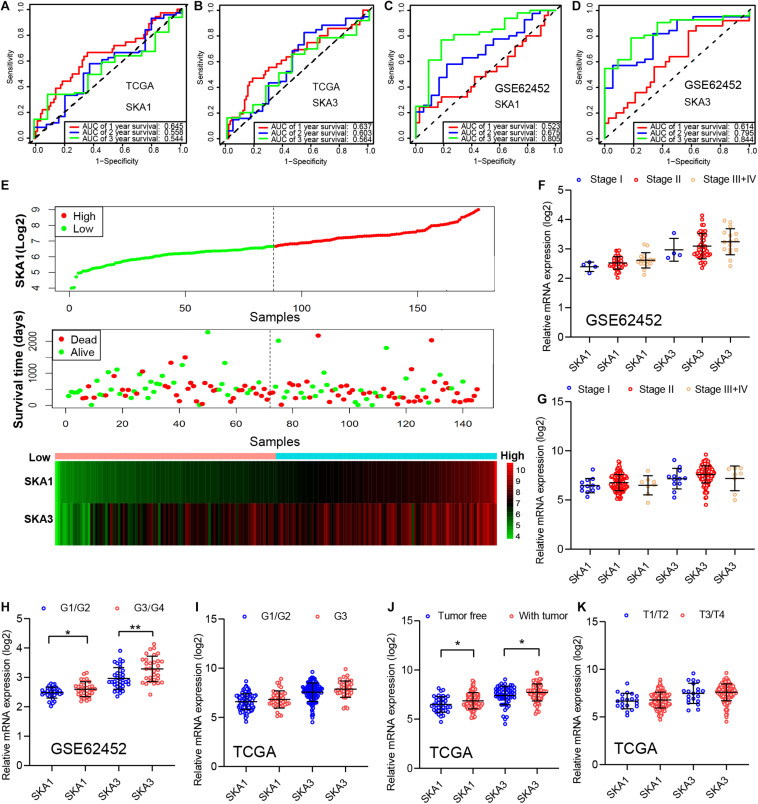
Analysis of the prognostic value and clinical relevance of SKA1 and SKA3 in pancreatic ductal adenocarcinoma patients. (A–D) Time-dependent receiver operating characteristic (ROC) curves of SKA1 and SKA3 showing the 1-, 2-, and 3-year overall survival rate of patients with PDAC from TCGA and GSE62452 datasets. (E) From top to bottom are the expression values of SKA1, patients’ survival status distribution, and the expression heat map of SKA1 in the low- and high-expression groups. The expression distribution of SKA1 and SKA2 genes in different (F,G) AJCC stages and (J,K) grades in TCGA and GSE62452 datasets. (H,I) The expression distribution of SKA1 and SKA2 genes in different pathological T grade and cancer status in TCGA cohort. *p < 0.05, **p < 0.01, ***p < 0.001.